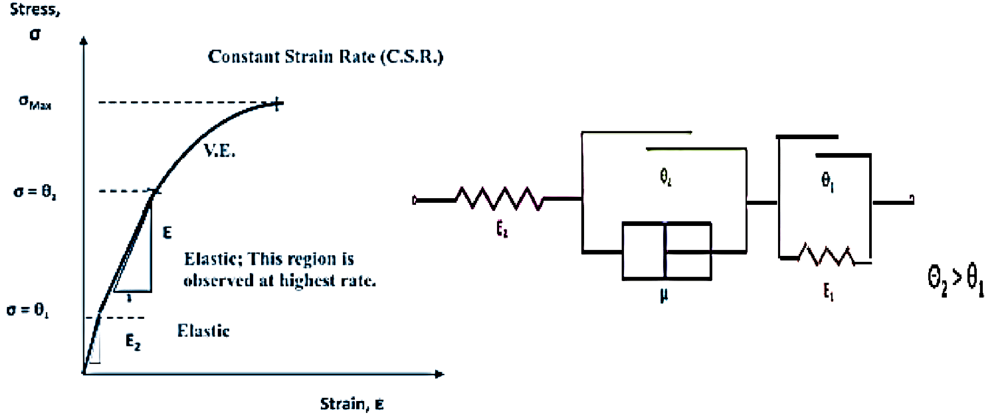
Figure 14. Illustration of (left) the proposed bilinear-viscoelastic model and (right) its representation with springs, dashpot and sliders.